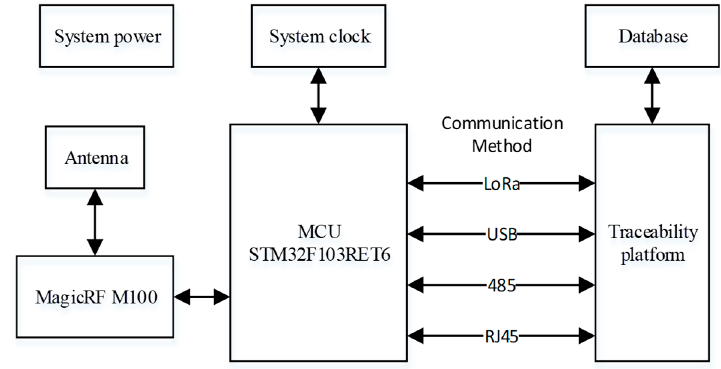
Figure 2. Hardware circuit design.